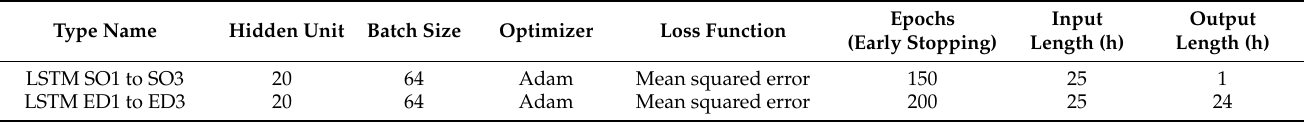
Table 3. Parameters of the developed